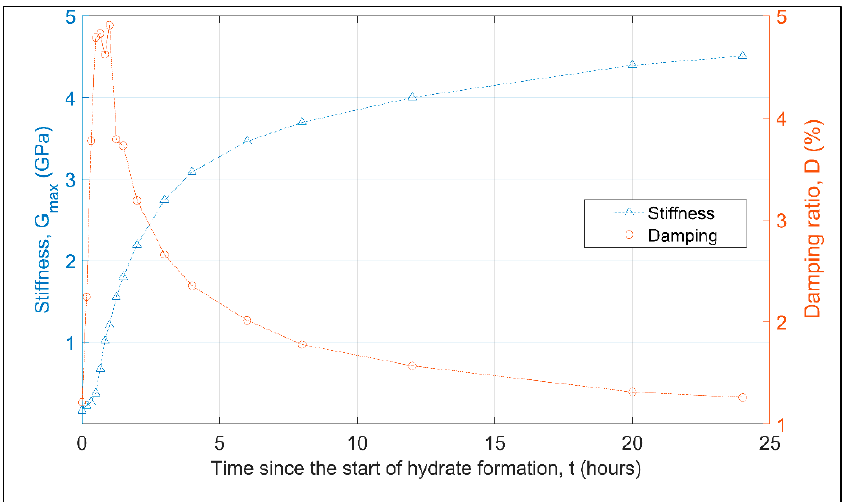
Figure 15. Increase in measured stiffness, G max (primary y -axis) and damping ratio (secondary y -axis) with time since start of hydrate formation.